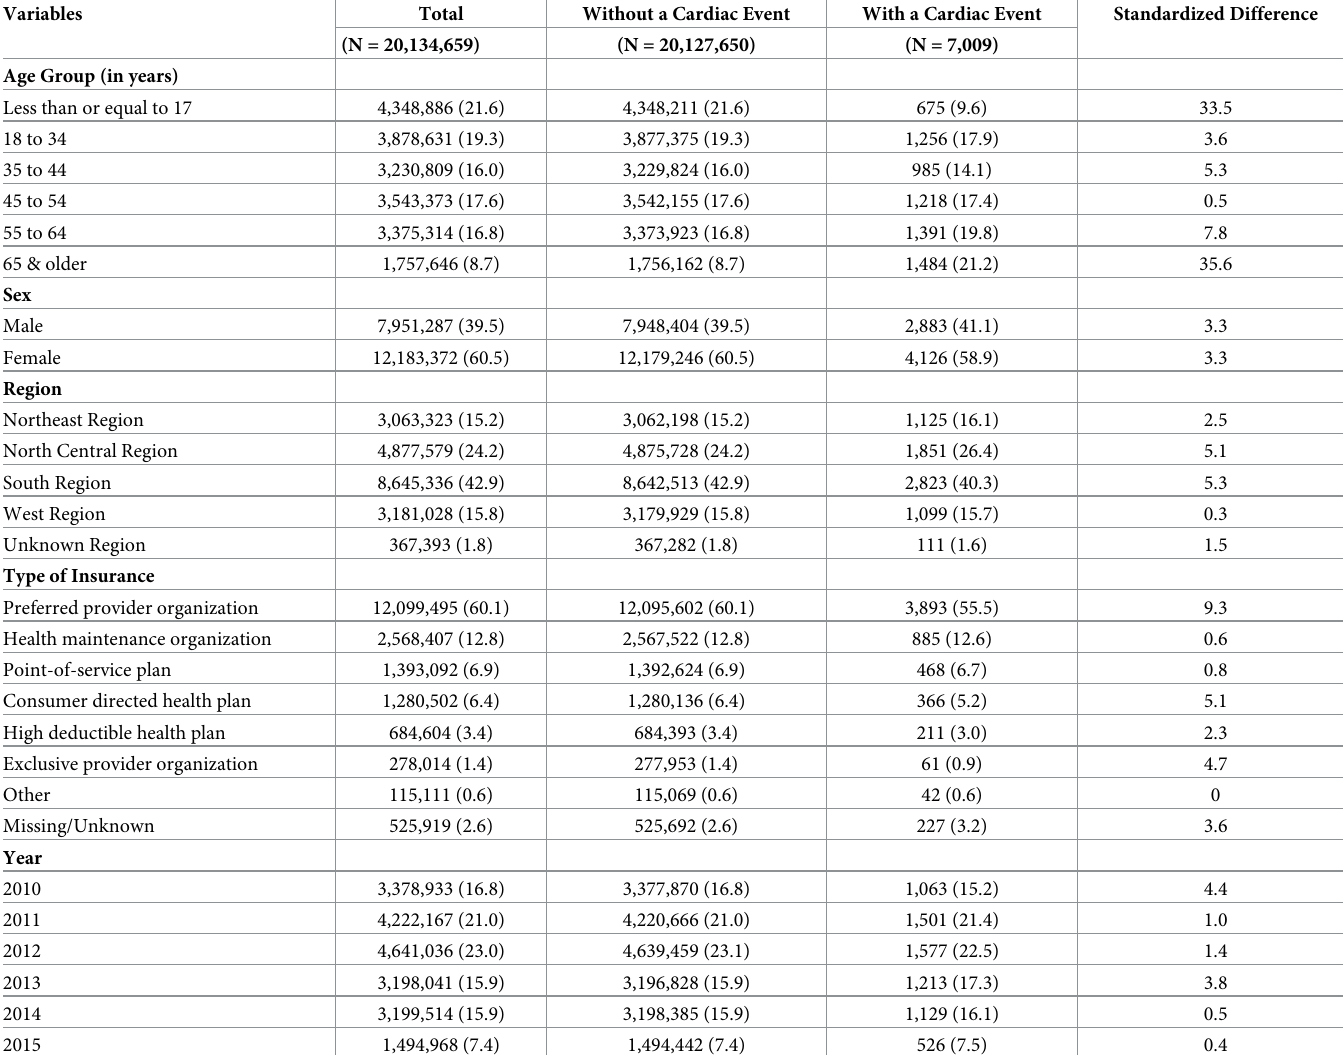
Table 1. Patient